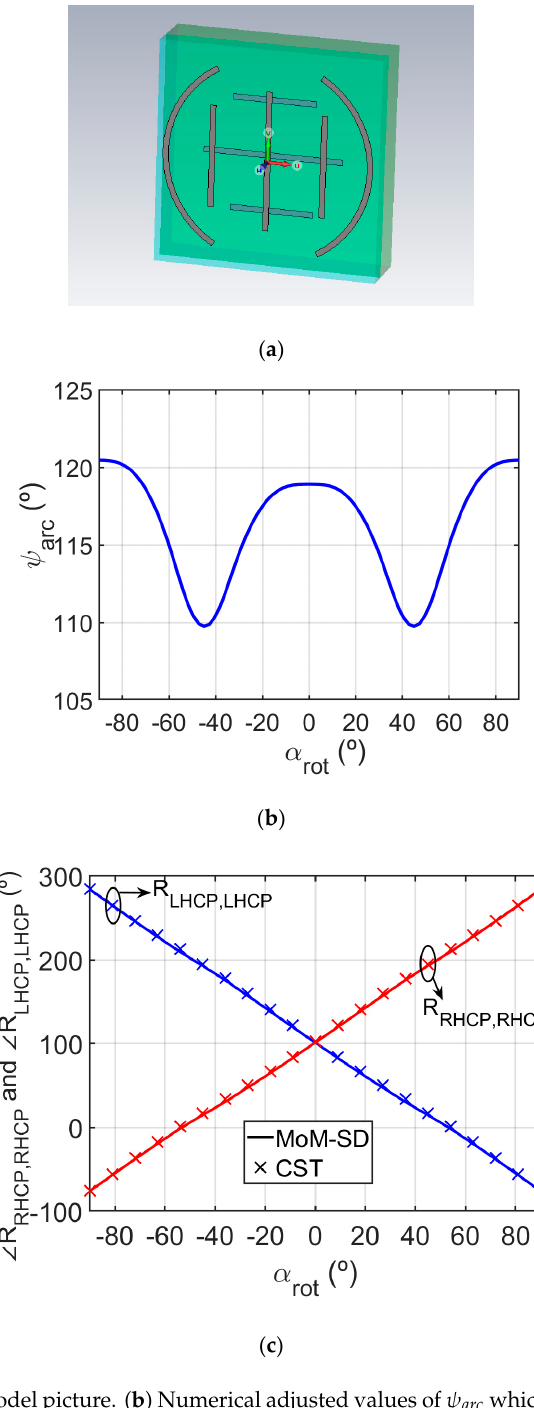
Figure 2. ( a ) 3D CST model picture. ( b ) Numerical adjusted values of ψ arc which preserve the condition R ’ 0 ,xx = − R ’ 0 ,yy as a function of the rotation angle α rot . ( c ) Simulated phase of the reflection coefficients R RHCP,RHCP and R LHCP,LHCP provided by the pairs ( ψ arc , α rot ) shown in ( a ) as a function of the rotation angle α rot . The numerical results are shown at 12 GHz under incidence angles θ i = 19°, ϕ i = 0° and fixed lengths of dipoles l dip , 21 = l dip , 22 = 5 mm.